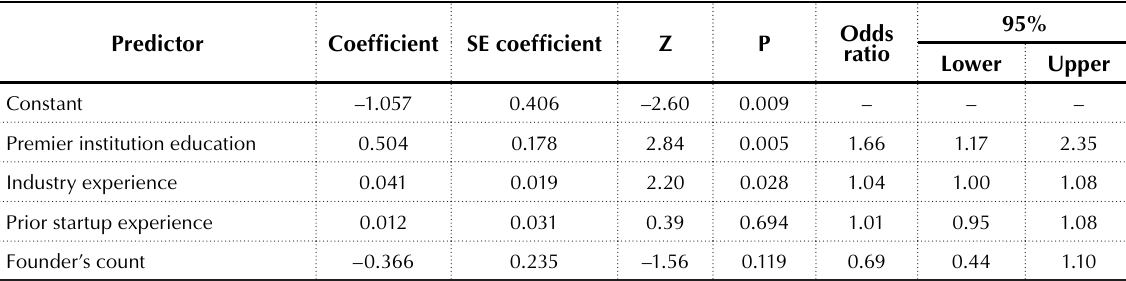
Table 4. Odds ratio for more than one round of